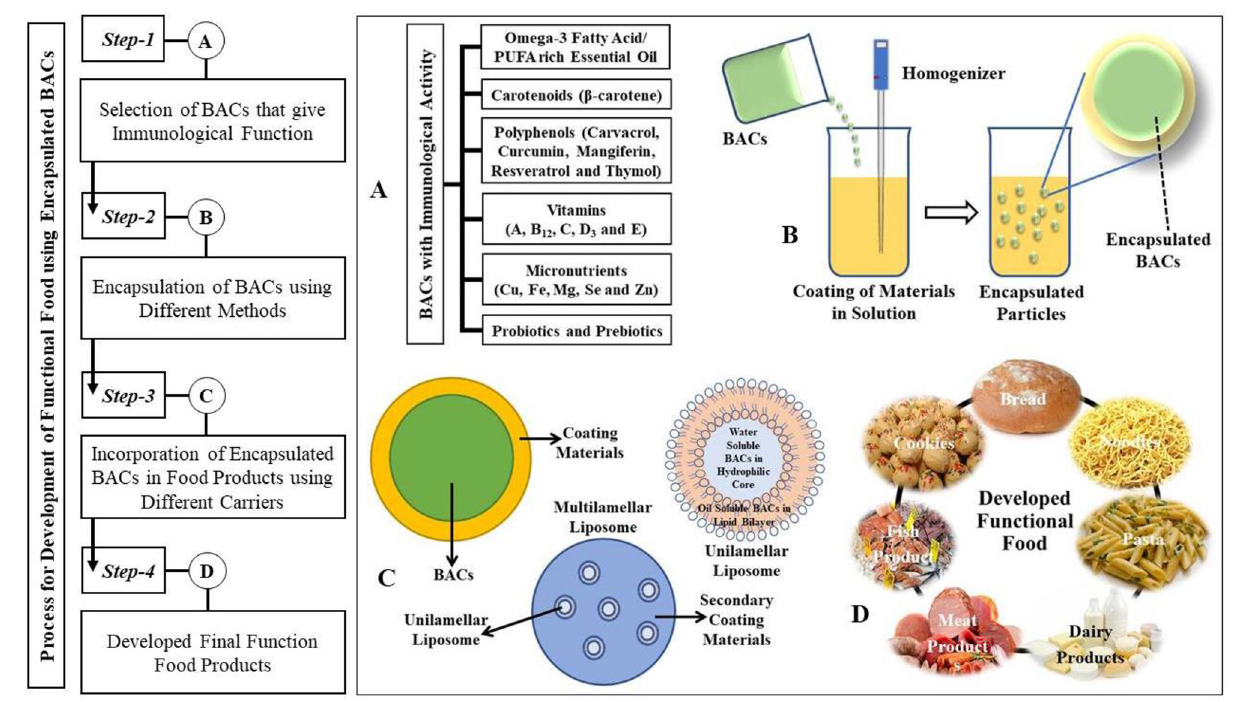
FIGURE 4 | A general flow schematic diagram for the development of functional food using encapsulated bioactive compounds (BACs) of immunological activity (96). (A) First, food-grade BACs that are supposed to substantially increase immunological function are chosen. (B) Second, nanoparticle-based carriers are used to encapsulate the BACs since they have shown promise in delivering BACs. Since functional food ingredients are delivered orally, they pass through the human gastrointestinal (GI) tract and are absorbed by enteric epithelial cells, which is why nanoparticle-based carriers are used to deliver BACs. However, low water solubility in human lumen fluid, results in low dispersal, reducing absorption. On the other hand, certain functional food additives may be degraded by an extremely low pH ( ∼ 2.0) of gastric fluid and digestion enzymes in the human stomach. (C) Following that, these encapsulated BACs are incorporated into food formulations